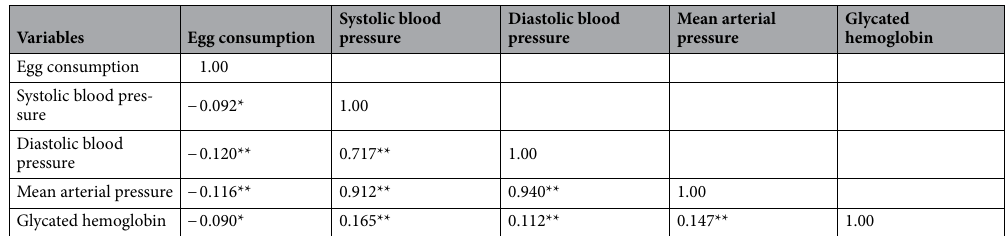
Table 2. Bivariate correlation between egg consumption and blood pressure parameters and glycated hemoglobin. Values indicate the correlation coefficient (r). * p < 0.050, ** p < 0.010. Egg consumption is in grams/day/kg of body weight unit, systolic, diastolic blood pressure and mean arterial pressure are in mmHg, and glycated hemoglobin is in percentage.